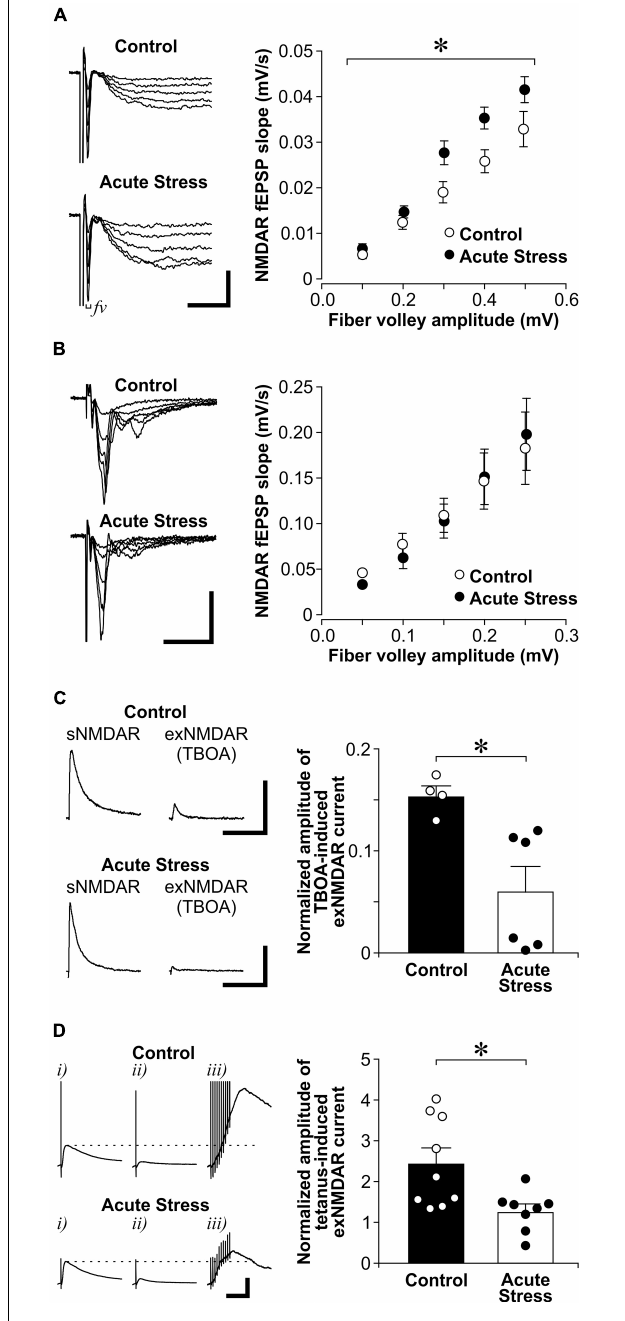
FIGURE 2 | Acute stress enhances sNMDAR and reduces exNMDAR functions. (A) Left : Representative traces of evoked NMDAR-mediated evoked field excitatory postsynaptic potential (fEPSP) that were recorded from brain slices of control and acutely stressed rats (restrained for 30 min). Scale bar = 0.2 mV, 10 ms. Right: Scatter plots show the relationship between fiber volley ( fv ) amplitude and the slope of NMDAR fEPSP in control (6 recordings, 3 rats) and stressed rats (6 recordings, 3 rats). Mean ± SEM. ∗ p < 0.05, interaction between the effect of stress and fiber volley amplitudes [repeated measures ANOVA, F (4, 40) = 3.46]. (B) Left: Representative traces of evoked AMPAR-mediated fEPSP that were recorded from brain slices of control